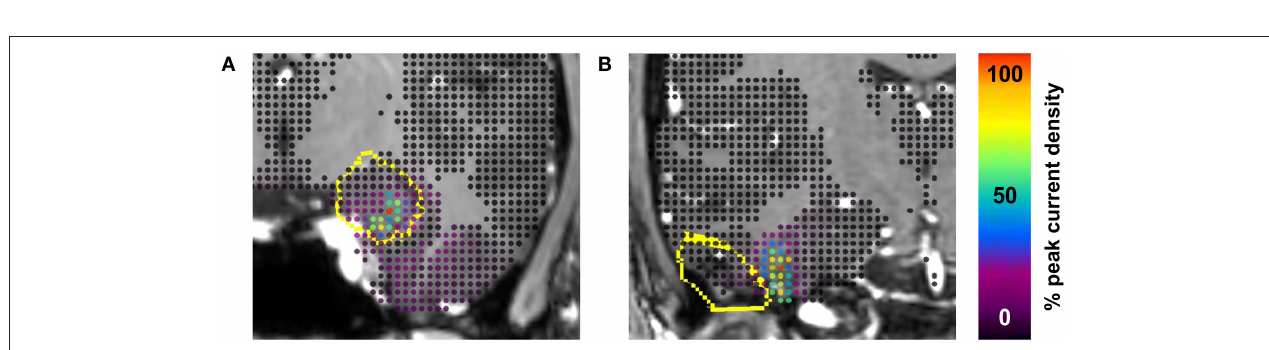
FIGURE 2 | Prediction of seizure freedom based upon proportion of current within the treatment volume (TV). (A) Histogram comparing proportion of above-cutoff current within the TV, using a lower cutoff of 50% of the maximum point current. “Patients” refers to proportion of patients in each outcome group (Engel I vs. Engel II–IV) within each histogram bin. (B) Receiver-operating characteristic (ROC) curve for SWARM with a 50% cutoff.